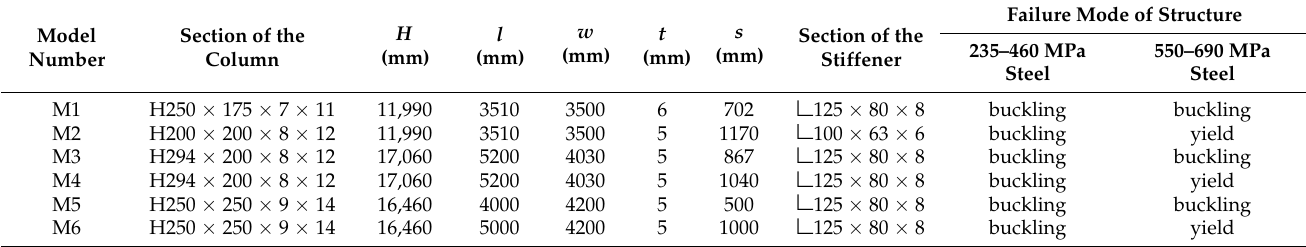
Table 1. Geometric parameters and failure modes of research models.